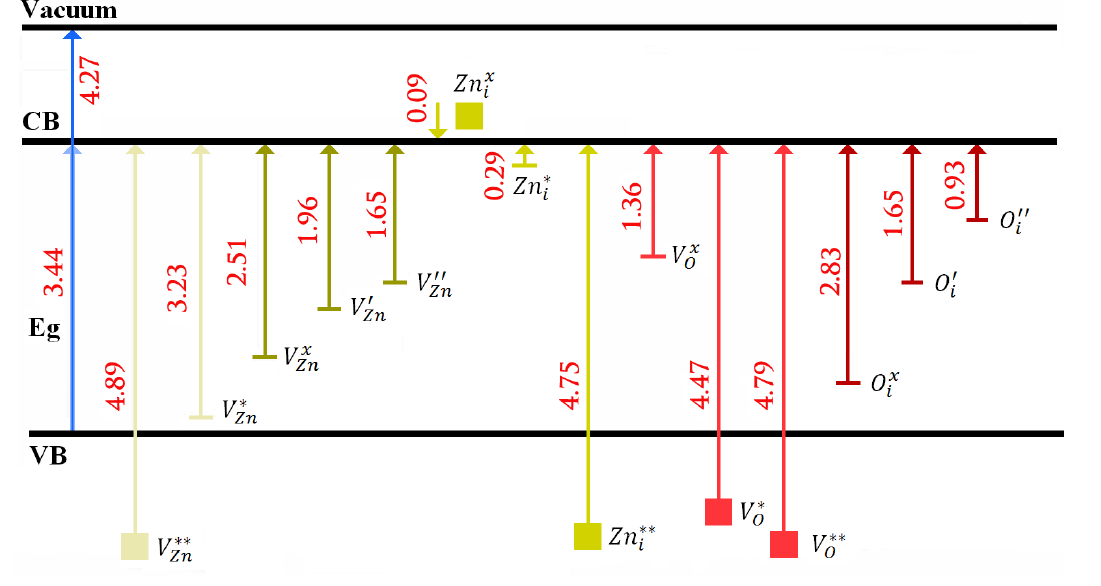
Figure 13. Energy levels of intrinsic defects in ZnO using Kröger Vink notation: i = interstitial site, Zn = zinc, O = oxygen, and V = vacancy. The terms indicate the atomic sites, and superscripted terms indicate charges, where a star indicates positive charge, a prime indicates negative charge, and a cross indicates zero charge, with the charges in proportion to the numbers of symbols (values of energy in